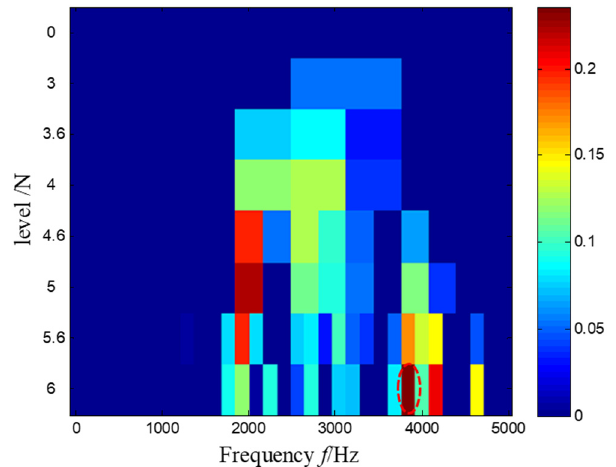
Figure 32. The Kurtogram and the optimal frequency band highlighted by a red dash circle.